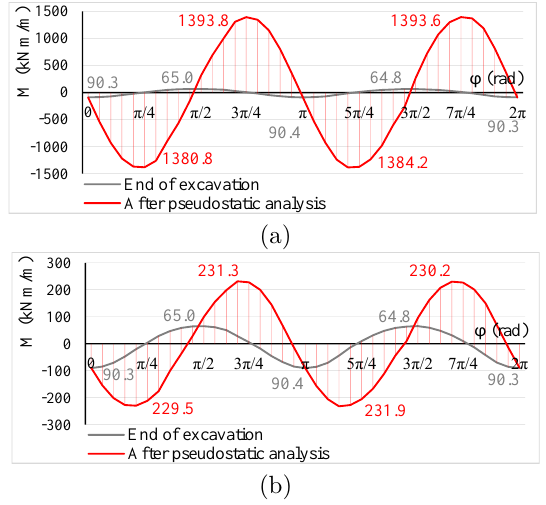
Figure 9. Distribution of moments prior to and after running the pseudostatic analysis: a) fixed boundary, b) absorbing